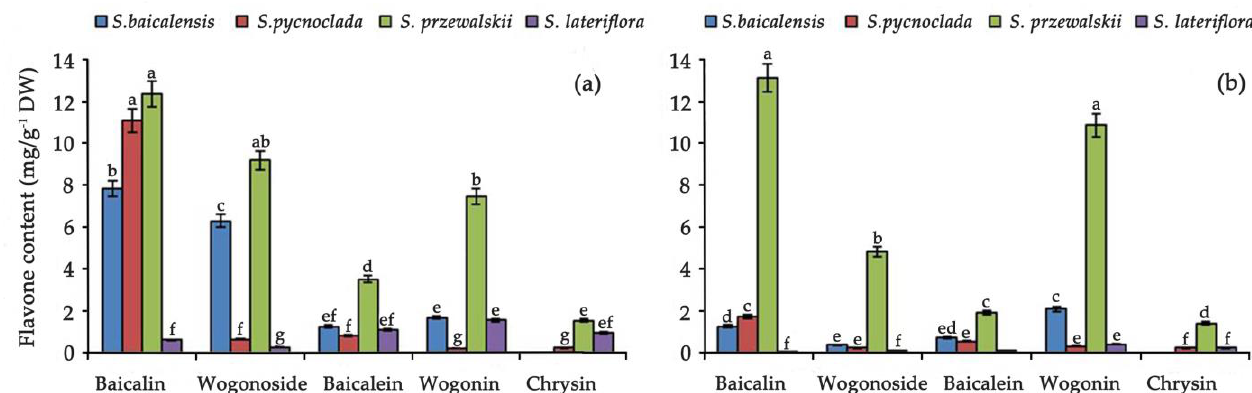
Figure 5. Comparison of the flavones content in the hairy roots of species of the genus Scutellaria , ( a ) in liquid medium, ( b ) on solid medium. Values are presented as the means ± SD. Different letters indicate a significant difference between the means (one-way ANOVA, p < 0.05).